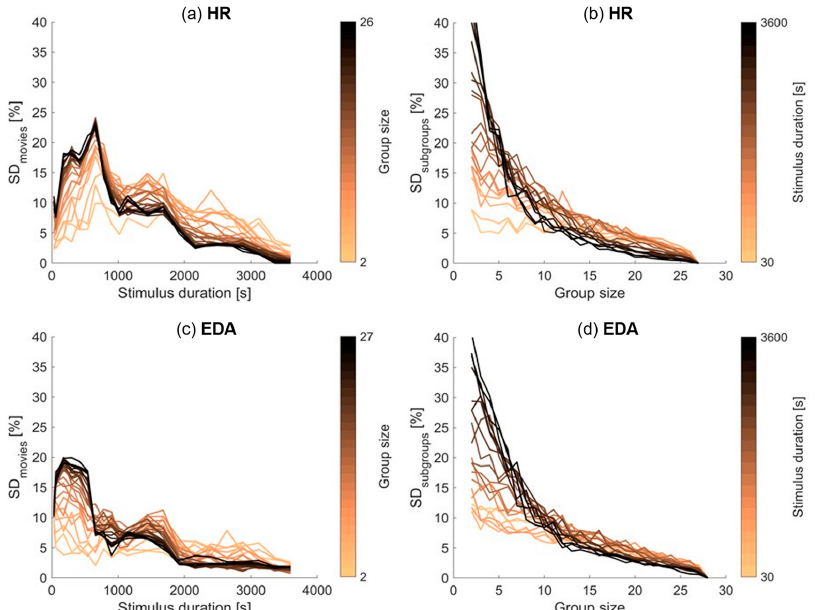
Figure 3. Standard deviation across movies ( left a , c ) and subgroups ( right ; b , d ) of the percentage of participants with significant inter ‐ subject correlations for HR ( top ); ( a , b ) and EDA ( bottom ; c , d ) as a function of stimulus duration ( left ; a , c ) and participant group size ( right ; b , d ). The color of the lines refers to the group size in the left plots and to the stimulus duration in the right plots.